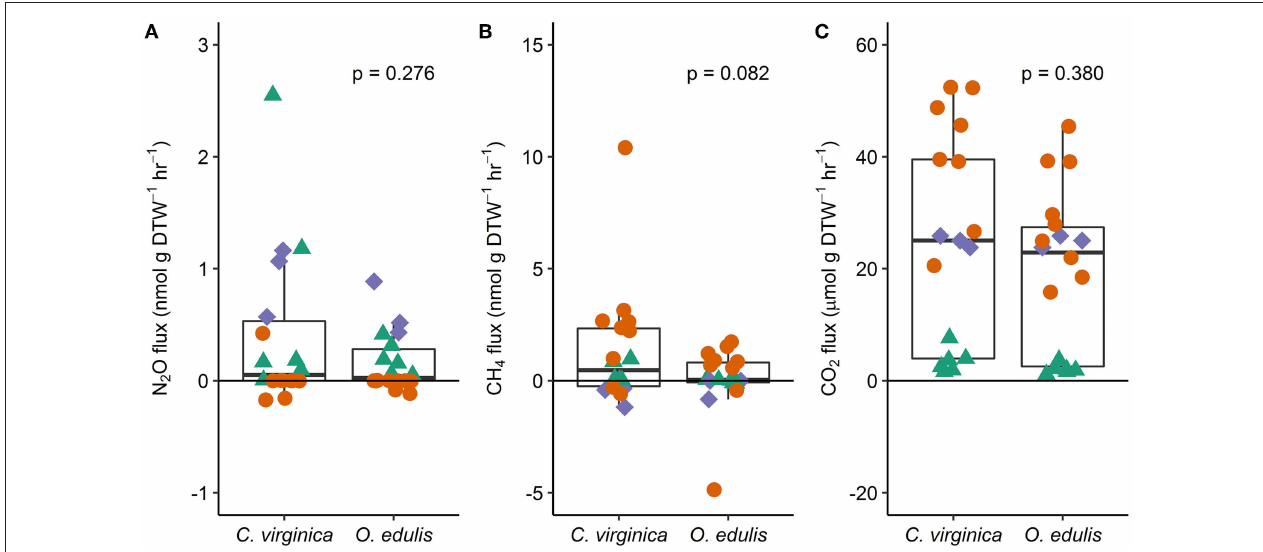
FIGURE 1 | Fluxes of nitrous oxide (A) , methane (B) , and carbon dioxide (C) from native ( C. virginica ) and non-native oysters ( O. edulis ); n = 18 for each species and flux, except n = 17 for C. virginica CO 2 fluxes. P -values show the result of least squares means tests comparing the mean flux between the native and non-native oysters. Each point represents an individual flux measurement (spring: green triangles, summer: orange circles, and fall: blue diamonds). Points below the zero-line show net consumption, and points above show net production.